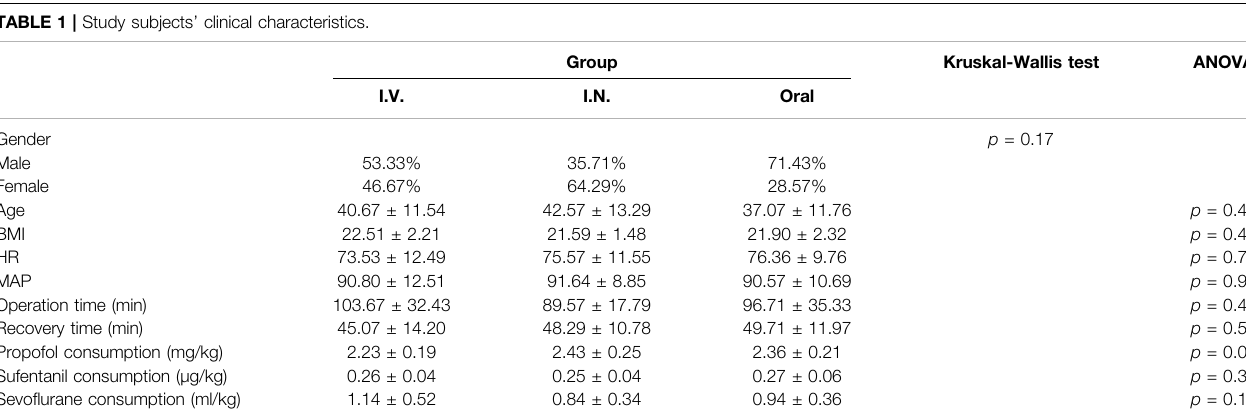
TABLE 1 | Study subjects ’ clinical characteristics.